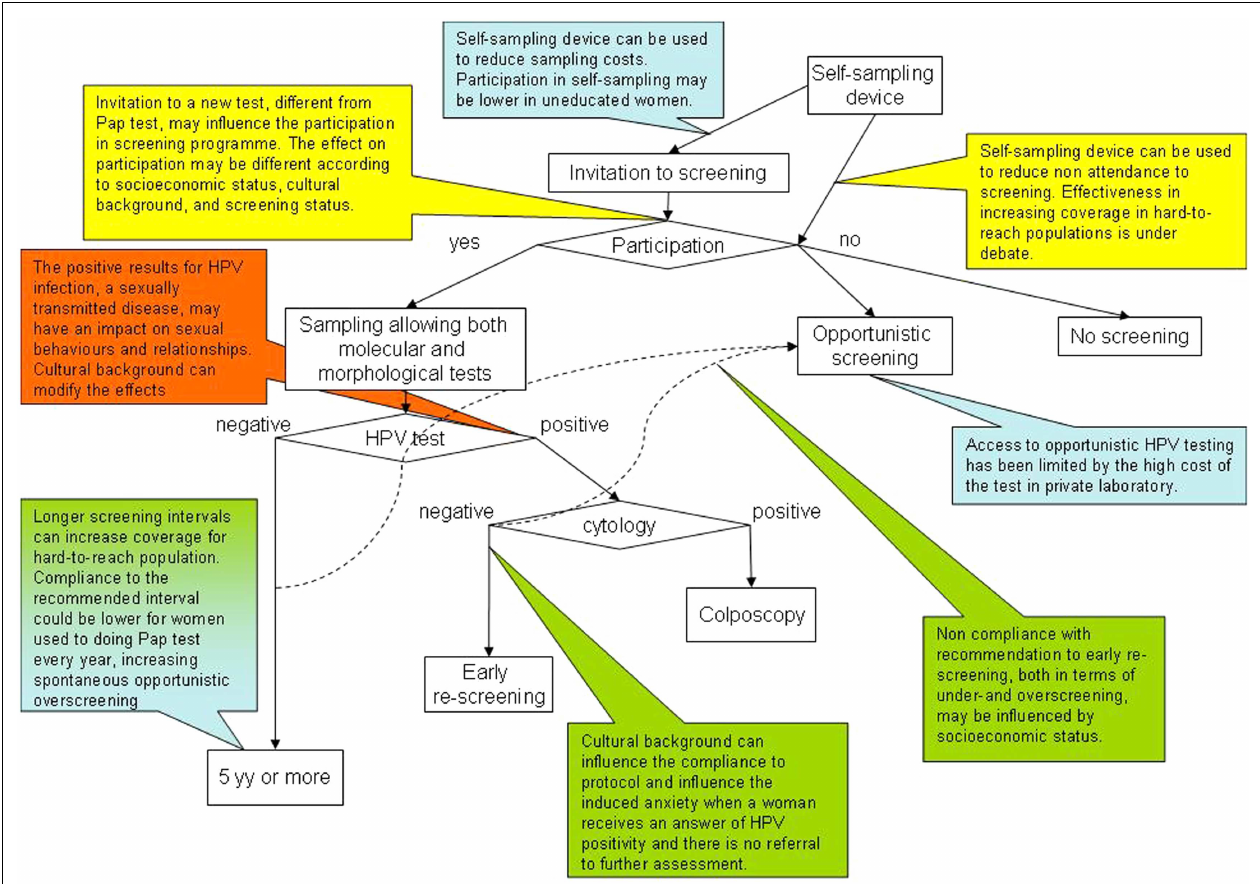
callouts corresponds to the main topics, as reported in Table 1 and Figure 2 , to which the critical point refers: in blue, points related to test coverage of the target population; in yellow, points related to participation in screening programs; in green, points related to compliance with screening protocols; in orange, points related with communication of positive results and